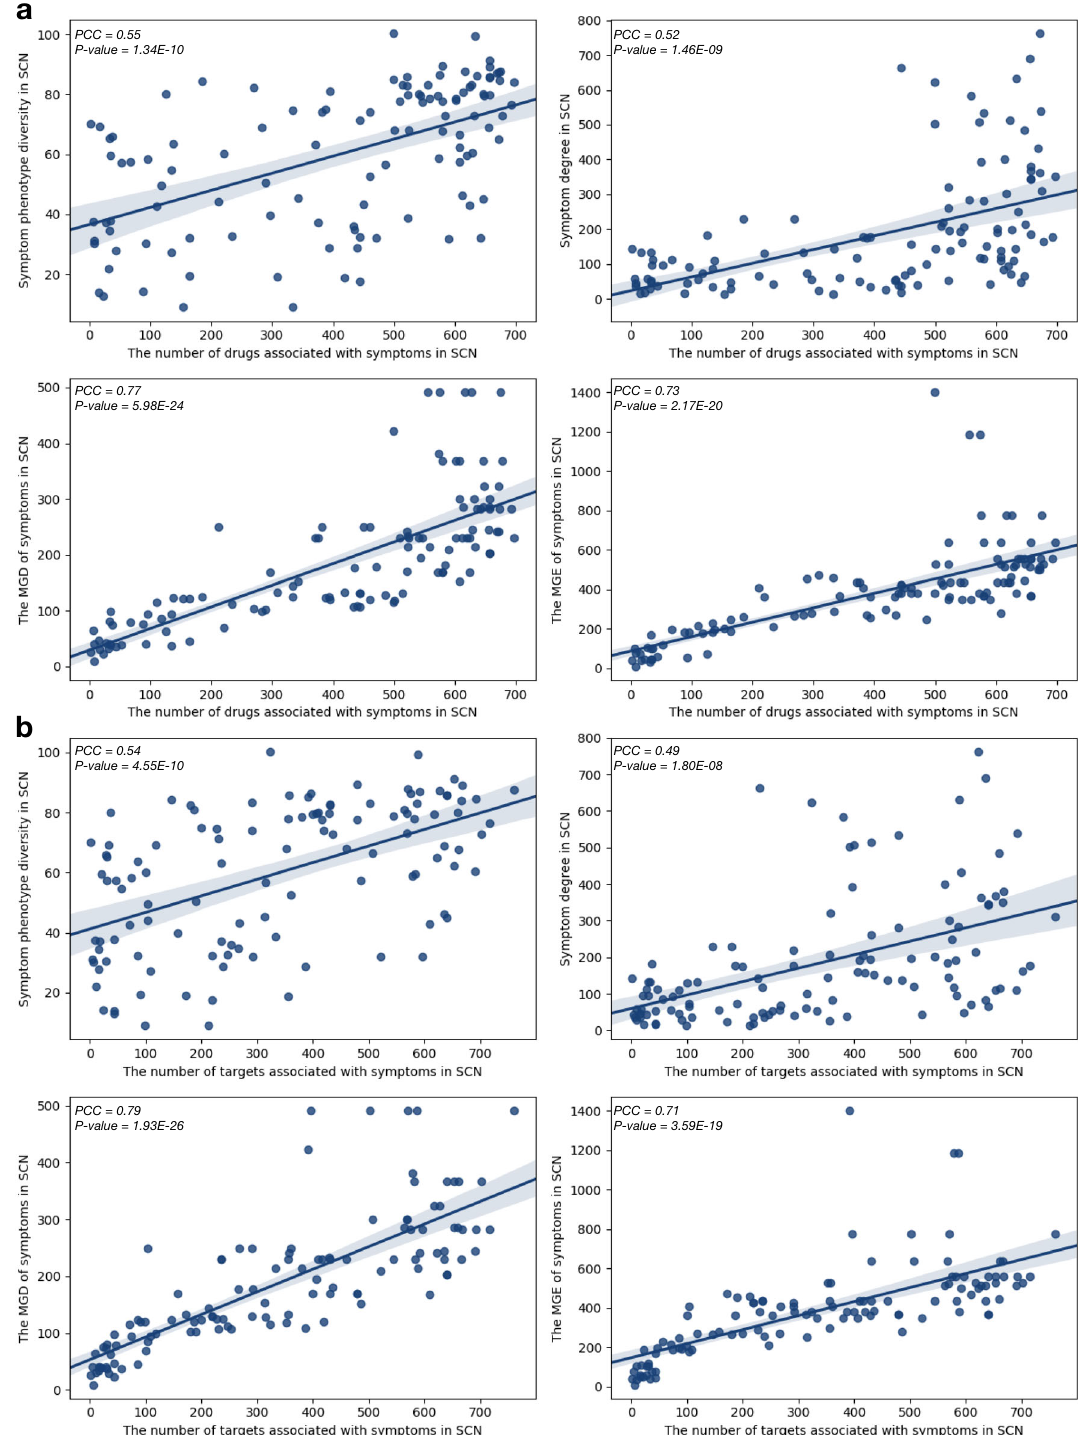
Fig. 5 Correlations of the symptom network diversity and related drug-targets diversity. a Correlations between the symptom diversity (phenotypic and molecular networks) and the number of related drugs. b Correlations between the symptom diversity (phenotypic and molecular networks) and the number of related would deliver population strati fi cation with higher speci fi city than symptom clusters which can help improve the capability of clinical single symptom phenotype. In our study, using the molecular diagnosis, treatment and predict the outcomes in patients rather diversity measurement of symptom phenotypes, we further than individual symptoms. Altogether, symptom clusters have investigate the underlying network mechanisms of symptom proposed an effective approach for symptom subtyping, which